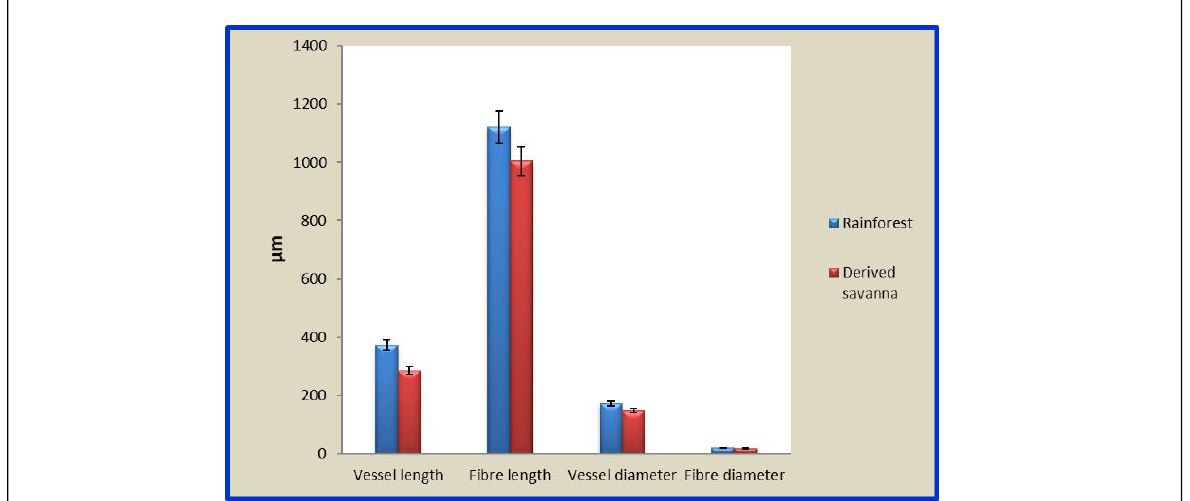
Figure 1: Vessel and fiber lengths and diameters of B. sapida growing in the rainforest and derived savanna regions of Edo state